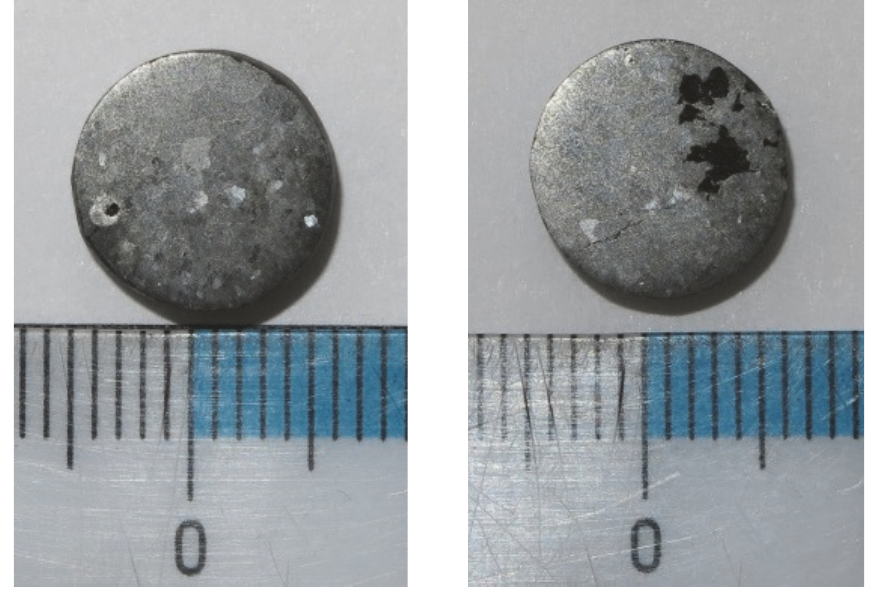
Figure 3: Physical configuration of sample.